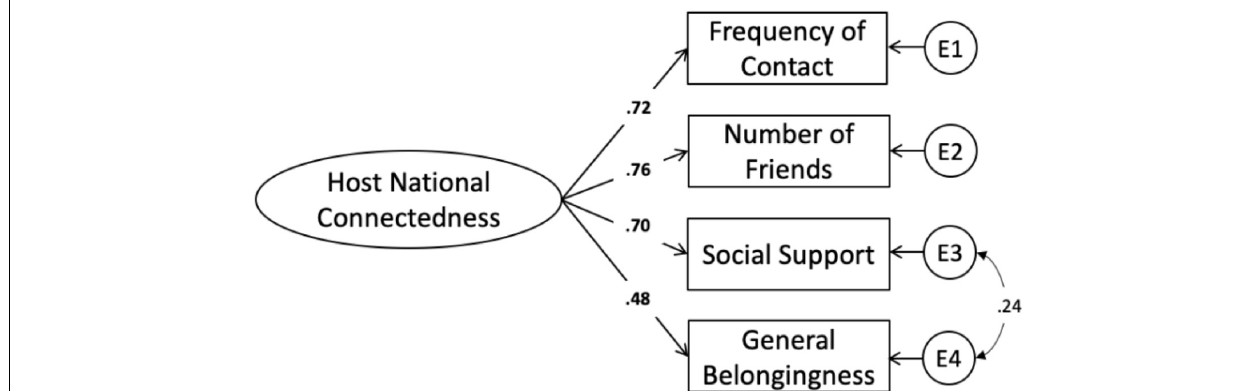
FIGURE 1 | HNC confirmatory factor analysis.